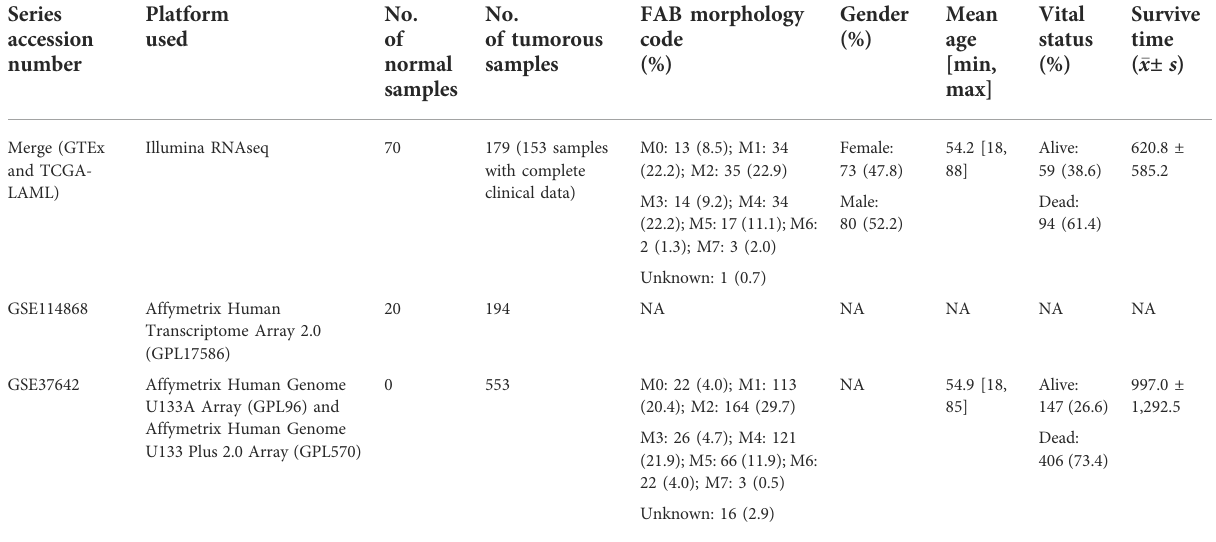
TABLE 1 Basic information on datasets in the